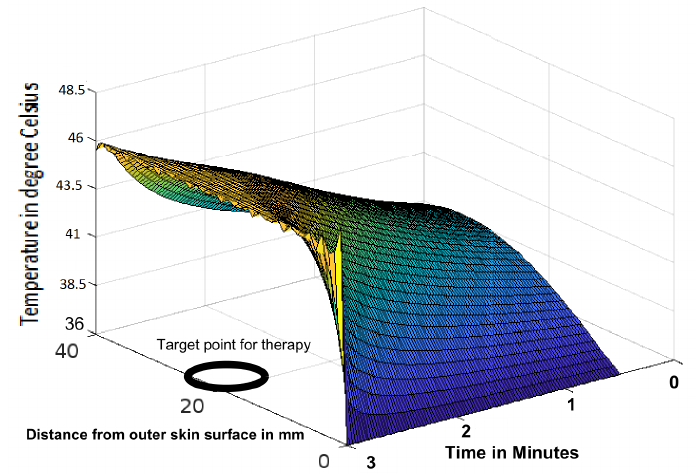
Figure 2. Variation of temperature profiles during thermotherapy at a temperature of 46 ◦ C targeted to a tumour located in a human